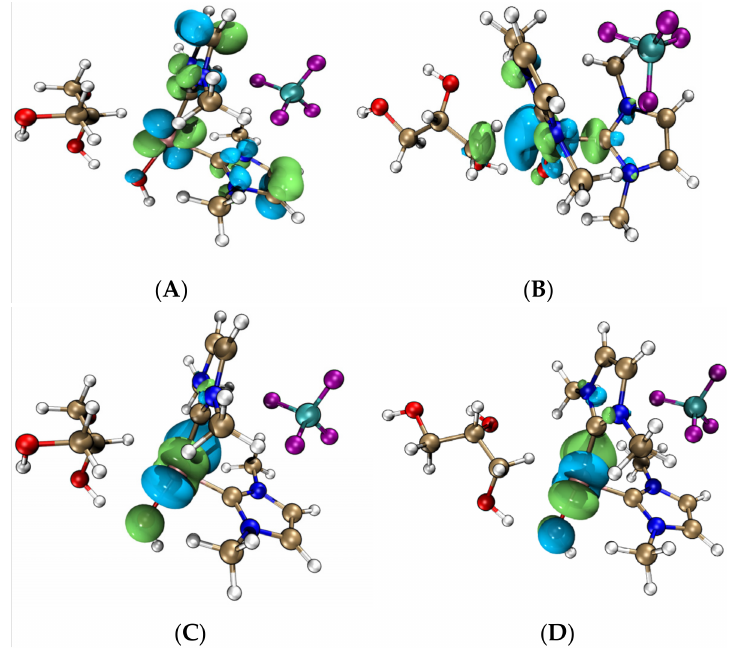
Figure 9. Diagrams of LUMO orbitals: ( A ) gal- α -LUMO ( − 1.89 eV); ( B ) gly- α -LUMO ( − 1.54 eV); ( C ) gal- β -LUMO ( − 3.69 eV); ( D ) gly- β -LUMO ( − 3.47